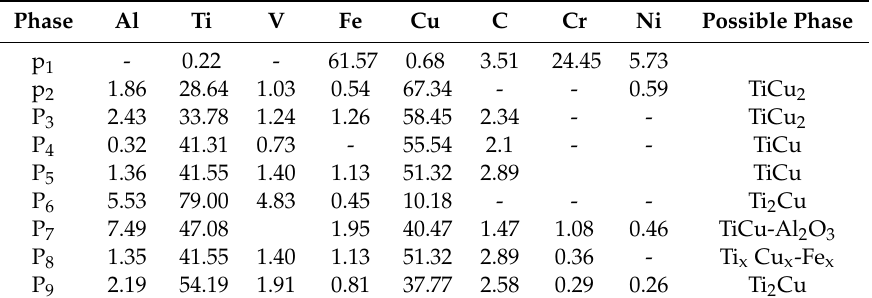
Figure 7. ( A ) Diffusion bonding of Ti-6Al-4V and super-duplex stainless steel (SDSS) using Cu/Al 2 O 3 Figure 7. ( A ) Di ff usion bonding of Ti-6Al-4V and super-duplex stainless steel (SDSS) using Cu / Al 2 O 3 interlayer for 30 min at a bonding temperature of 850 °C; ( B ) Detail micrograph of the region-1; ( C ) interlayer for 30 min at a bonding temperature of 850 ◦ C; ( B ) Detail micrograph of the region-1; Ti/SDSS couple joined using 25 µm Cu-foil interlayer for 30 min at a bonding temperature of 850 °C; ( C ) Ti / SDSS couple joined using 25 µ m Cu-foil interlayer for 30 min at a bonding temperature of 850 ◦ C; ( D ) Detail of region-2 [68]. ( D ) Detail of region-2 [68]. Table 2. Composition of the bond interface measure with EDS (wt %) [68] Table 2. Composition of the bond interface measure with EDS (wt %)